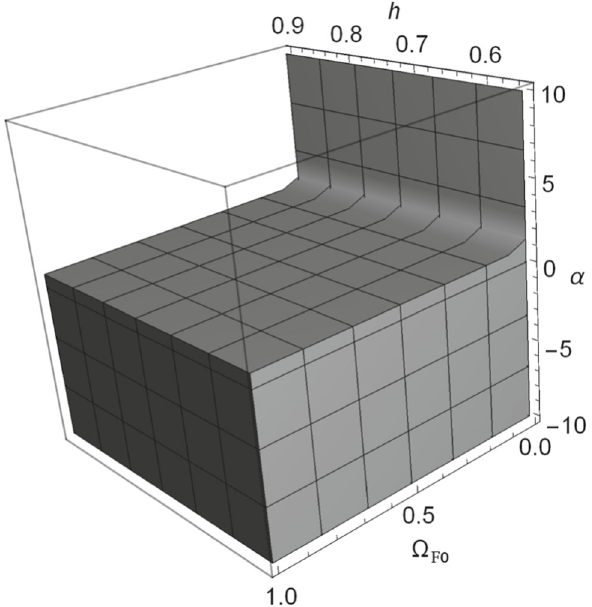
Fig. 1 The parameter space of the polynomial model (23) that is con- sistentwiththeBBNconstraints.Ifwealsodesirethemodeltobeableto describe dark energy in the late-time Universe we obtain the combined constraint α < 0